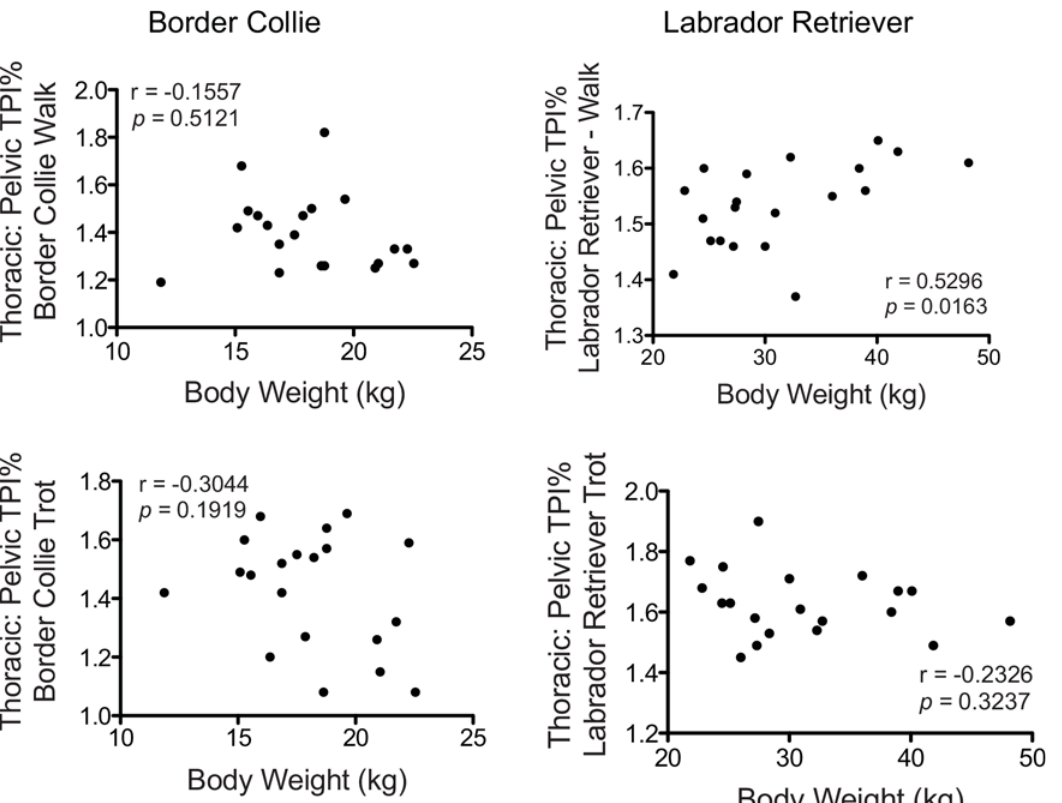
Fig 3. Thoracic to Pelvic Limb Total Pressure Index Percentage Ratio (T/P TPI%) compared to Body Weight at the Walk and Trot in Border Collies and Labrador Retrievers. There was no relationship between the ratio of thoracic to pelvic TPI% (T/P TPI%) and body weight at the trot for either breed (bottom left and bottom right) or for the Border Collies at the walk (top left). However, there was a significant positive correlation (p = 0.0163) between the ratio of weight borne on the thoracic limbs vs the pelvic limbs and body weight in the Labrador Retrievers at the walk (top right).